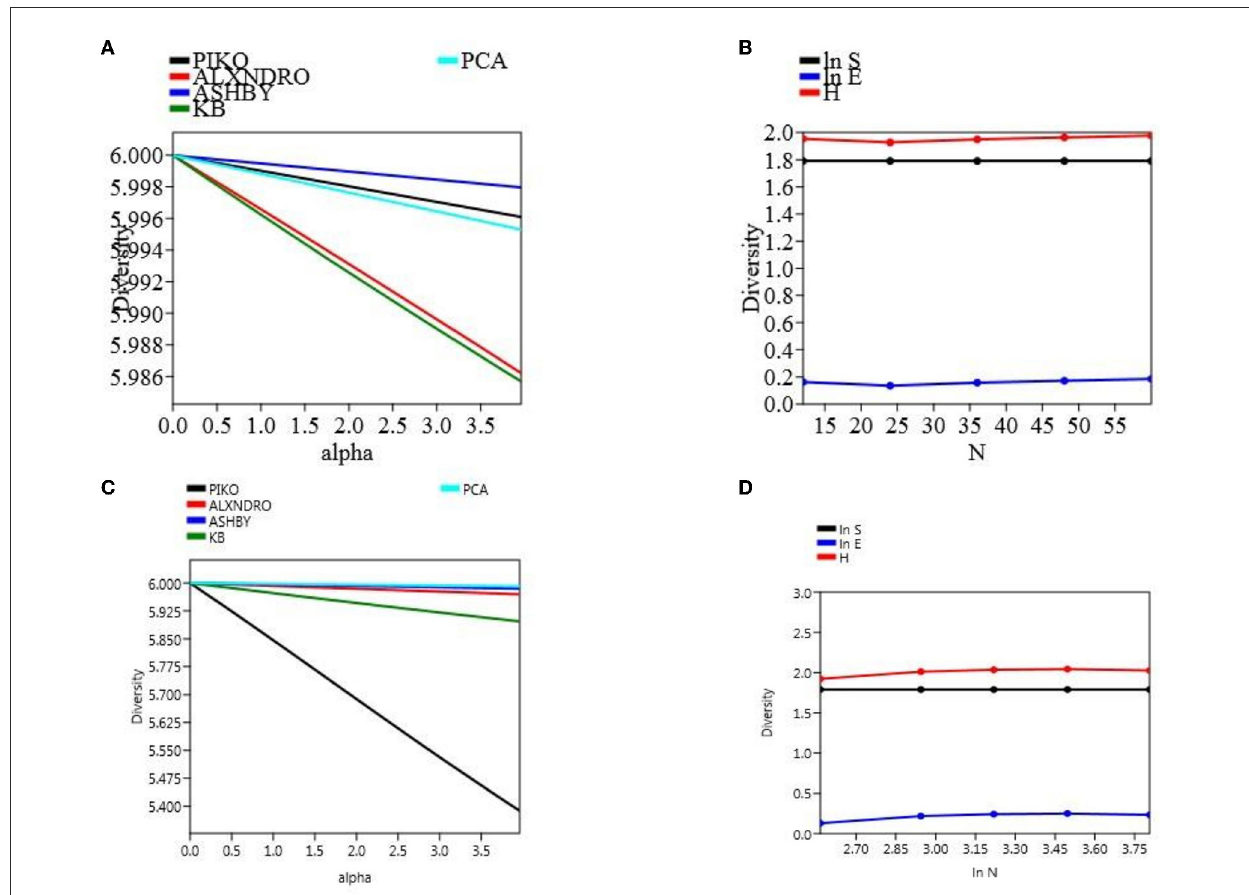
FIGURE8 α -diversity indices of the microbial population with different media of field type 1 (A) and S.H.E indices of the field set 1 (B) . α -diversity (C) indices and S.H.E indices (D) of the field set